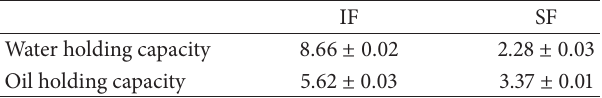
Table 12: Water and oil holding capacities of Agave fibres concen- trate (g/g of fibres